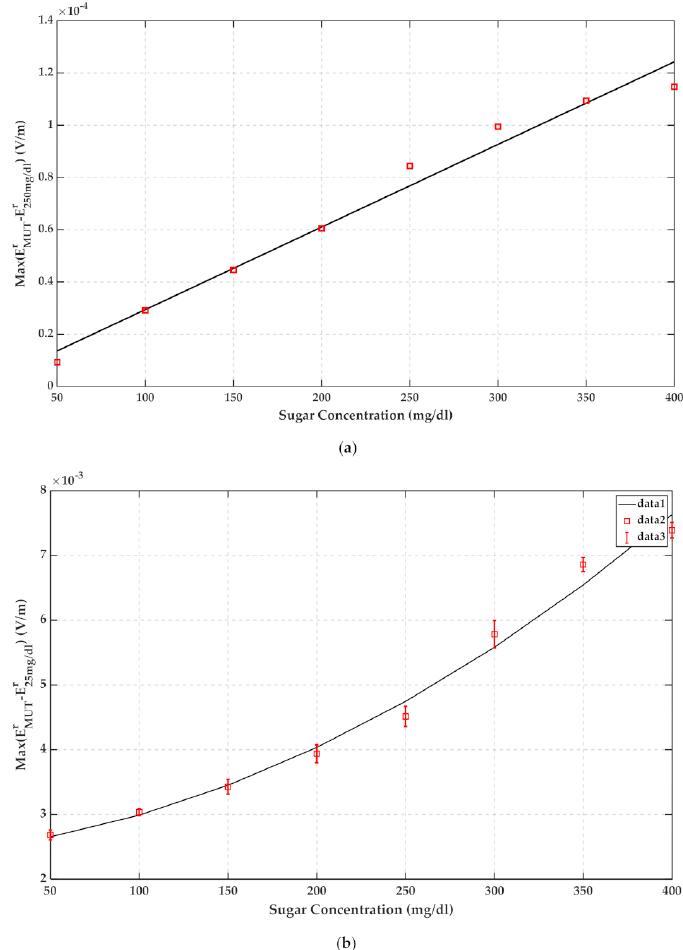
Figure 15. Maximum of reflected signals and corresponding linear fits as a function of glucose concentration ( a ) VNA measurement result ( b ) m-sequence radar measurement